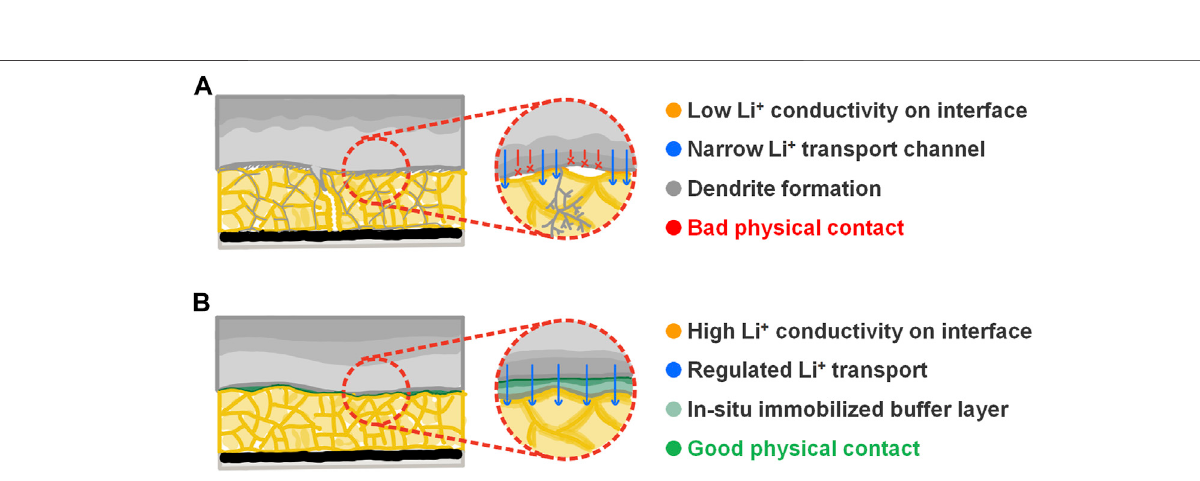
Frontiers in Chemistry |